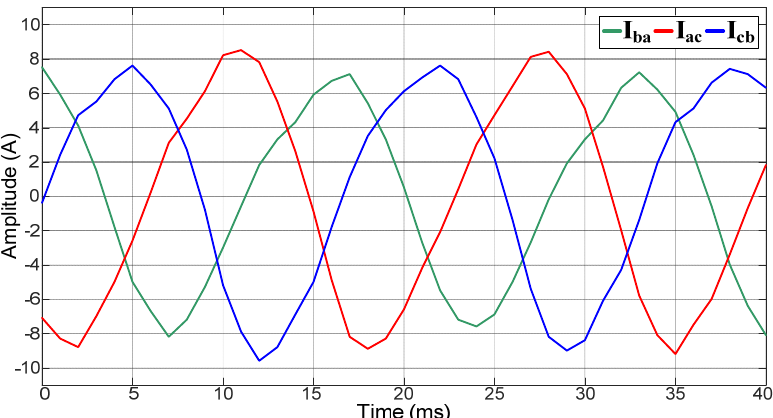
Figure 10. Line currents from an induction motor with a 5% short-circuit fault condition on phase-C of its stator winding.